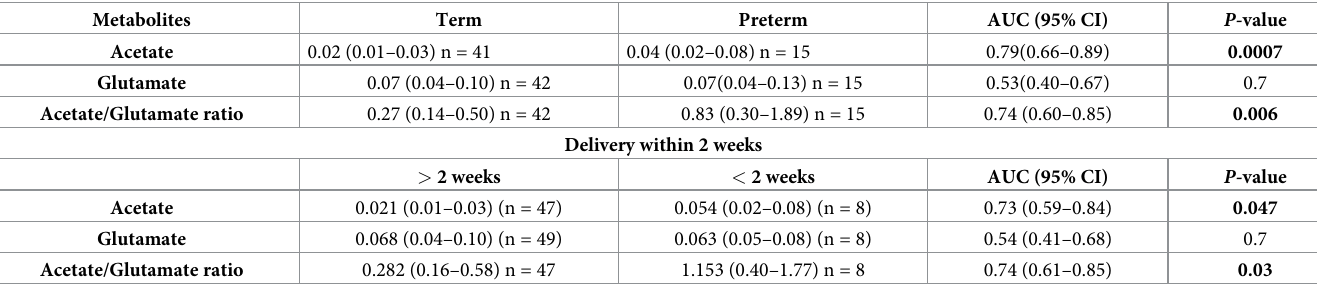
Table 3. Cervicovaginal fluid metabolites concentrations in relation to delivery